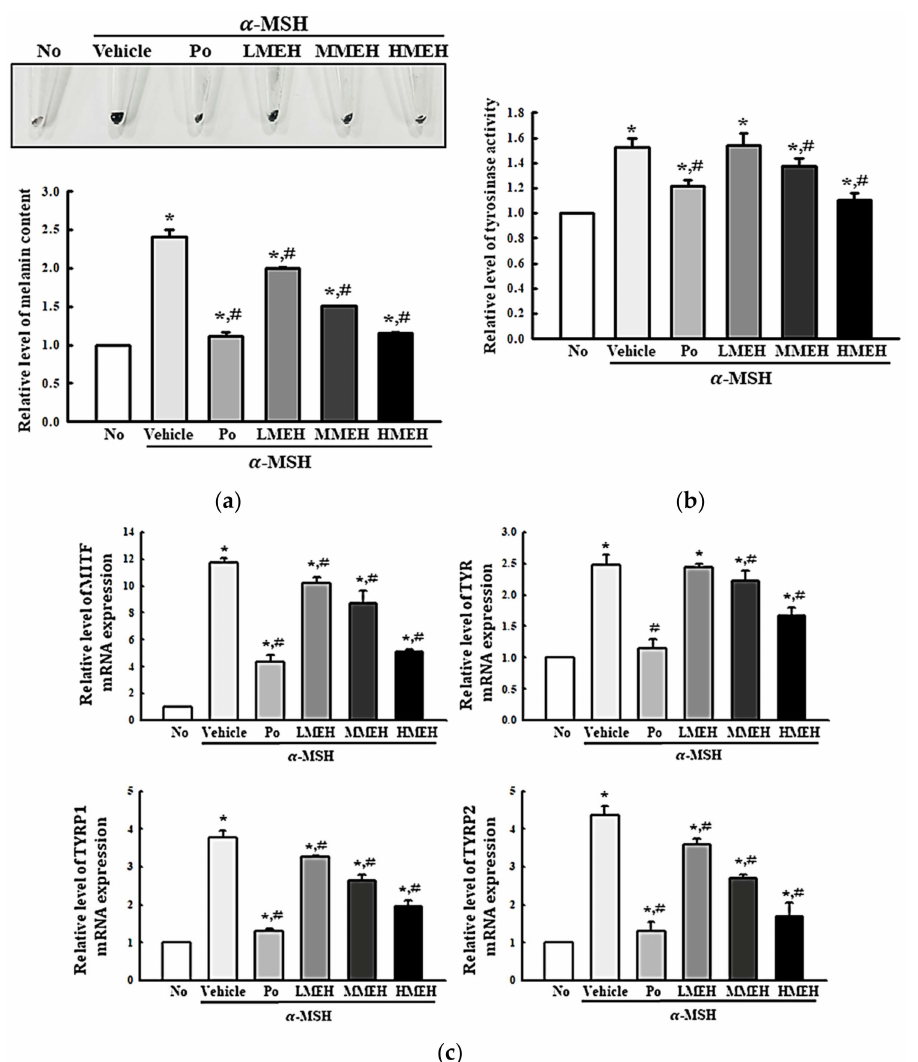
Figure 13. Regulation of melanin synthesis in B16F1 melanoma cells. ( a ) Melanin content analysis; ( b ) After preparing the cell lysates, the tyrosinase activity was measured with L-DOPA. Three to five dishes per group were used to prepare the cell lysates in duplicate. The melanin content was measured in triplicate. This experiment was performed for three times and results are the average of all experiments; ( c ) The levels of MITF, TYR, TYRP1, and TYRP2 mRNA were measured by RT-qPCR. Three dishes per group were used to prepare the total RNAs. RT-qPCR was performed in triplicate. This experiment was performed for three times and results are the average of all experiments. Data are reported as the means ± SD of triplicate. *, p < 0.05 compared to the untreated group. #, p < 0.05 compared to the UV + Vehicle group. Abbreviations: UV, Ultraviolet; RT-qPCR, Quantitative reverse transcription PCR; α -MSH, alpha-Melanocyte-stimulating hormone;